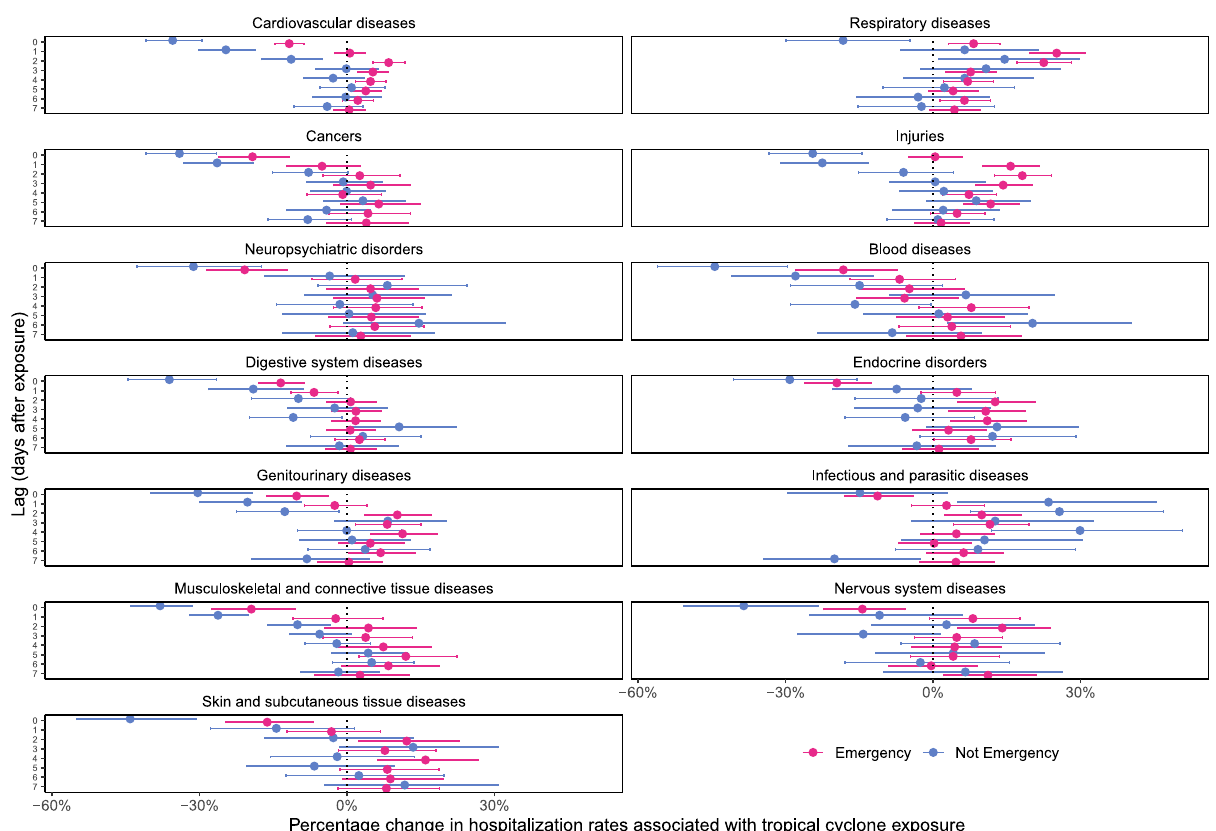
Fig. 6 Percentage change in hospitalization rates with tropical cyclone exposure by cause of hospitalization, type of hospital admission, and lag time. Lag time is measured in days after tropical cyclone exposure. Dots show the point estimates and error bars represent Bonferroni-corrected 95% con fi dence